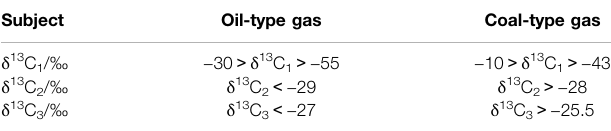
TABLE 3| Identi fi cation items ofcarbon isotopes and composition(after Daietal.,